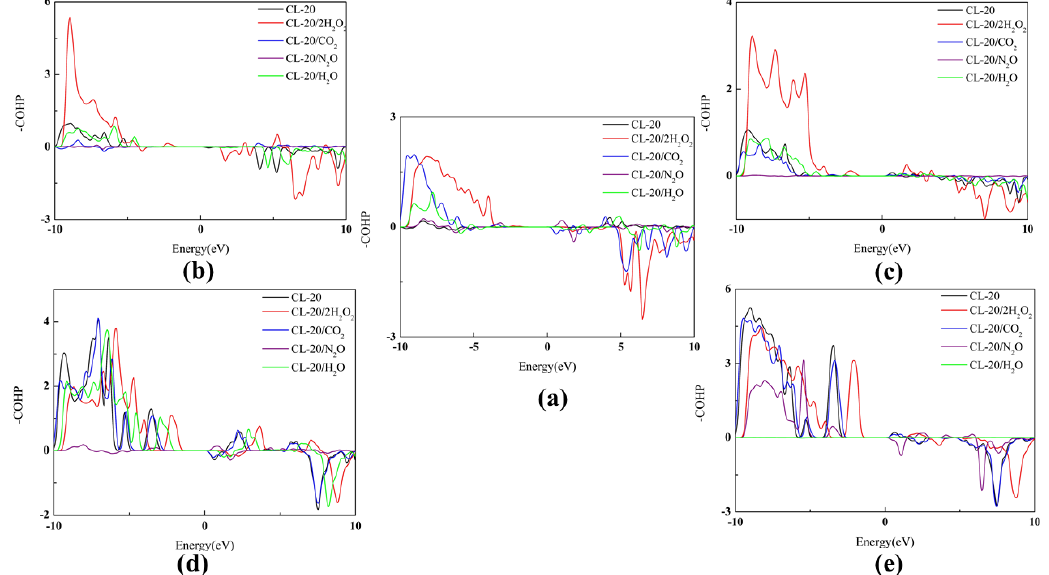
Figure 15. The -COHP curves for the CL-20 interactions of CL-20 and its complexes: ( a ) C-H bonds, ( b ) C-C bonds, ( c ) C-N bonds, ( d ) N-N bonds, and ( e ) N-O bonds, respectively. In the -COHP curves, the positive and negative signs represent bonding and antibonding states, respectively. The thick trendline corresponds to the actual concentration data of the corresponding matching color.